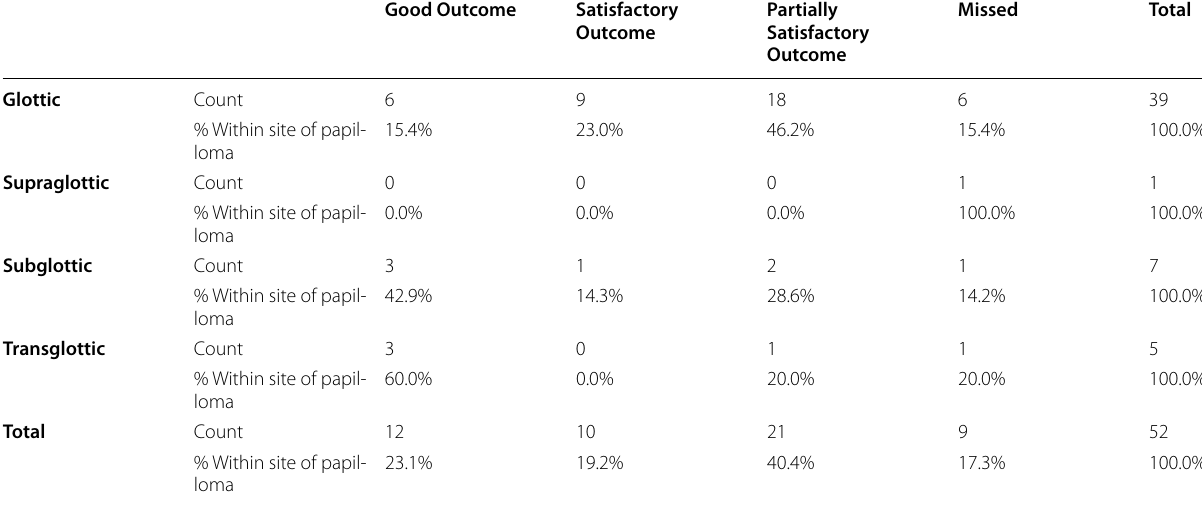
Table 3 Frequency distribution of the cases according to sites of the papilloma in relation to the outcome Good